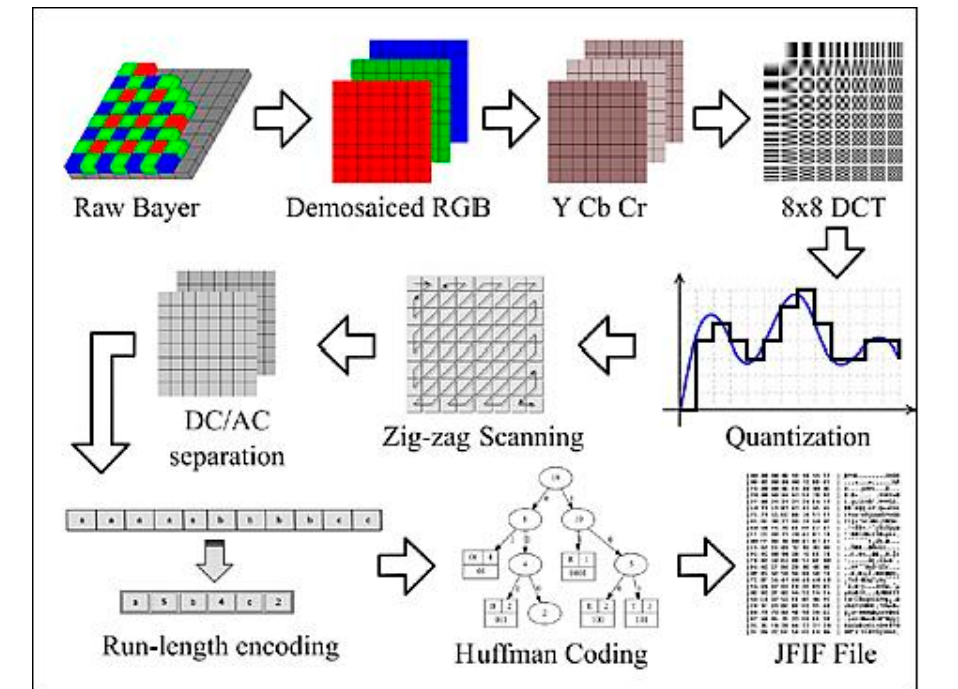
Figure 1. JPEG compression imaging workflow (image credit: SCSAG).